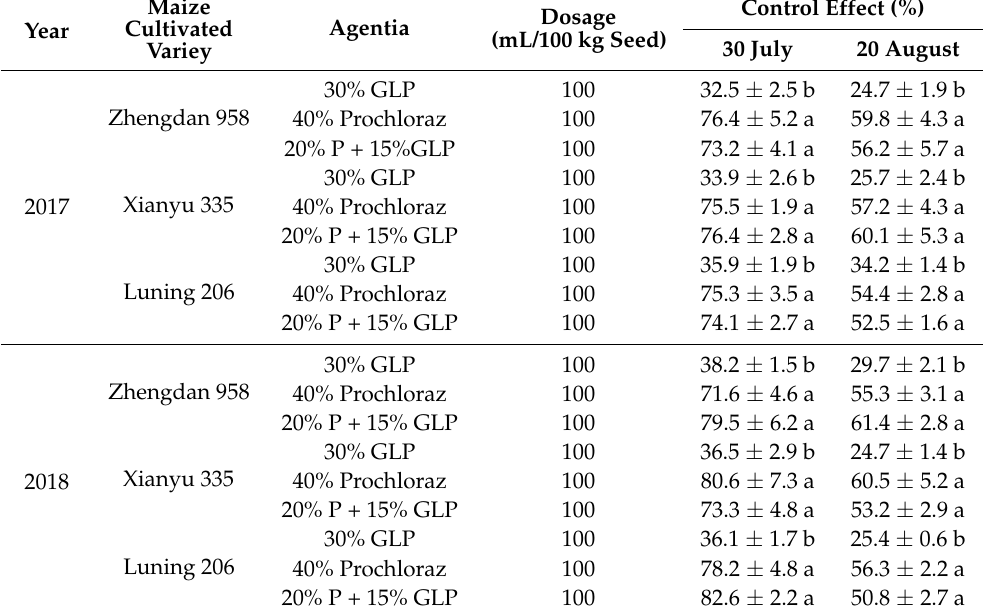
Table 13. Field control effect of seed treatment on maize stalk rot.